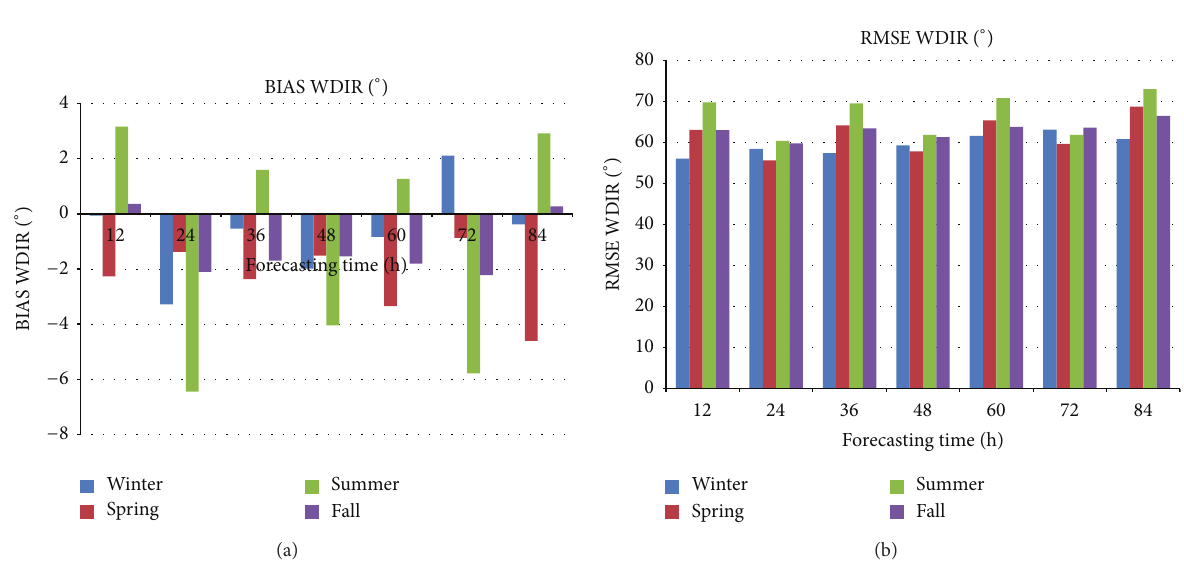
Figure 6: BIAS (a) and RMSE (b) for wind direction for the four